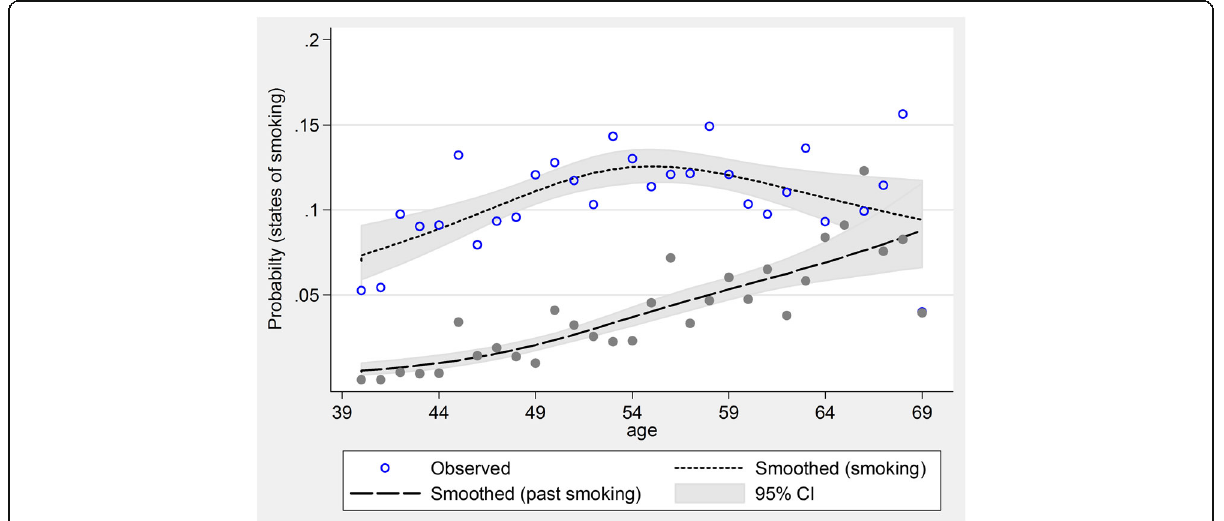
Fig. 3 The estimated probability of current tobacco use and overall past smoking using a restricted cubic regression model in Shahroud, Iran